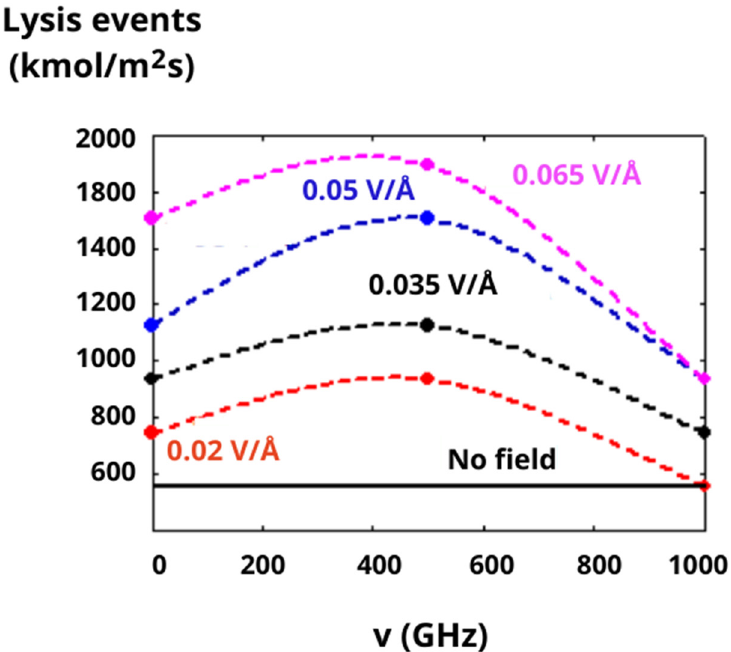
Figure 6. Counts of water dissociation occurrences from NE-AIMD per unit area, scaled up from ~12 ps trajectories from an initially dry surface [17].